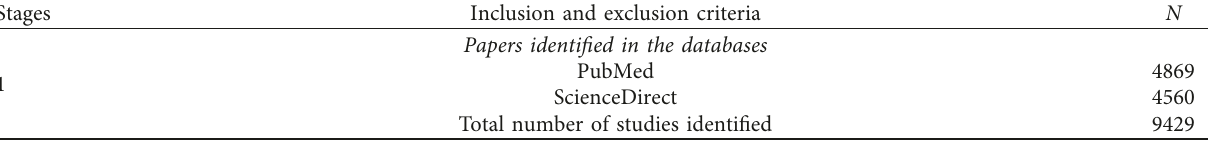
Table 1: Paper selection stages and inclusion and exclusion criteria for the systematic